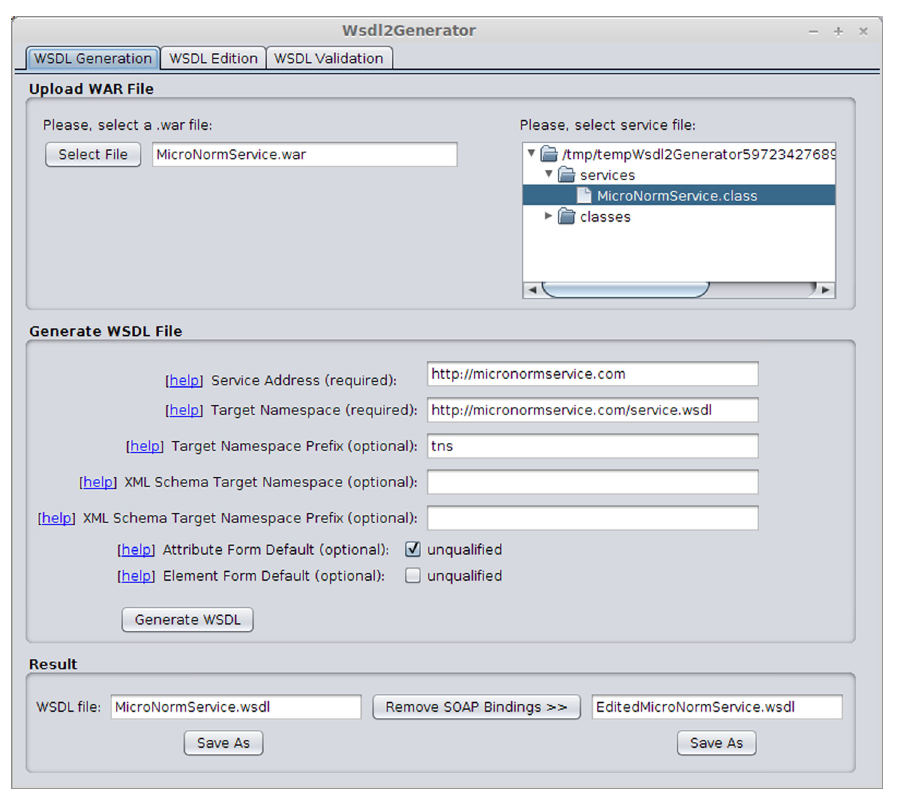
Fig 2. Screenshot of the Wsdl2Generator support